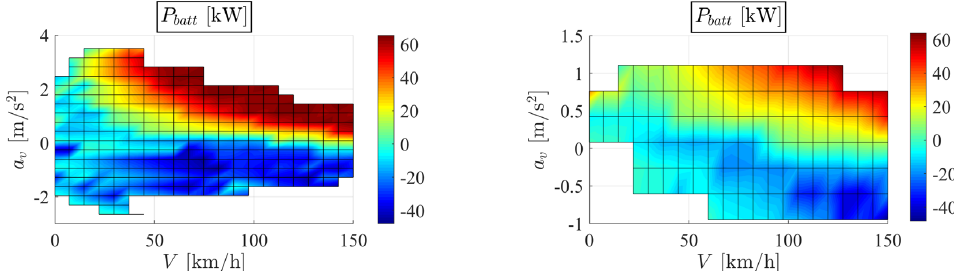
Figure 9. P batt maps for the Input Split ( left ) and Compound Split ( right ) modes and road slope α = Finally, the selection between Input Split and Compound Split modes is carried out by considering the one that guarantees the highest value of power-weighted efficiency in the whole range of the vehicle operating condition, as shown in Figure 10.